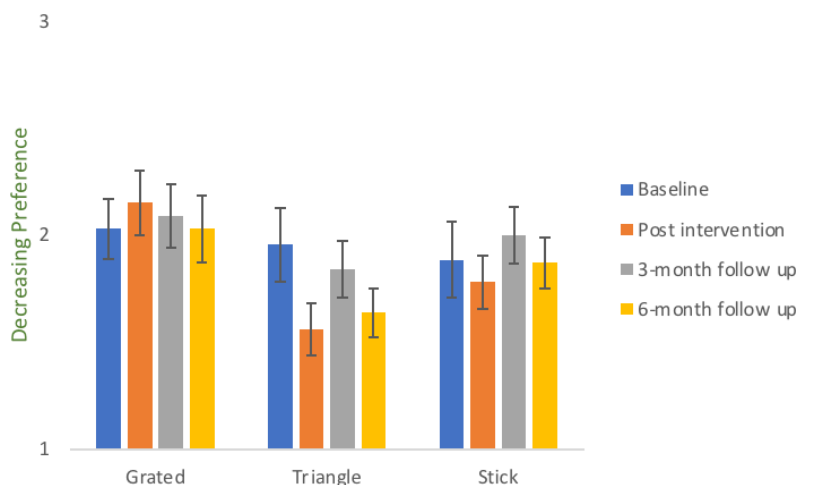
Figure 5. Ranking scores ± SEM for the different shapes of daikon throughout the control sessions. The scores that are illustrated represent the ranking of the respective serving style by the children that were exposed to that particular serving style of the same vegetable during the intervention. For ranking data, the evaluation scale used was 1 = most preferred, 2 = second preferred and 3 = least preferred, with the mean value of a highly ranked vegetable to contain the value “1” more times and therefore to have lower score than the least preferred vegetable which contains the value “3” more times. The lowest scores represent the highest preference. Similarly, the highest bars represent the least preferred serving styles.